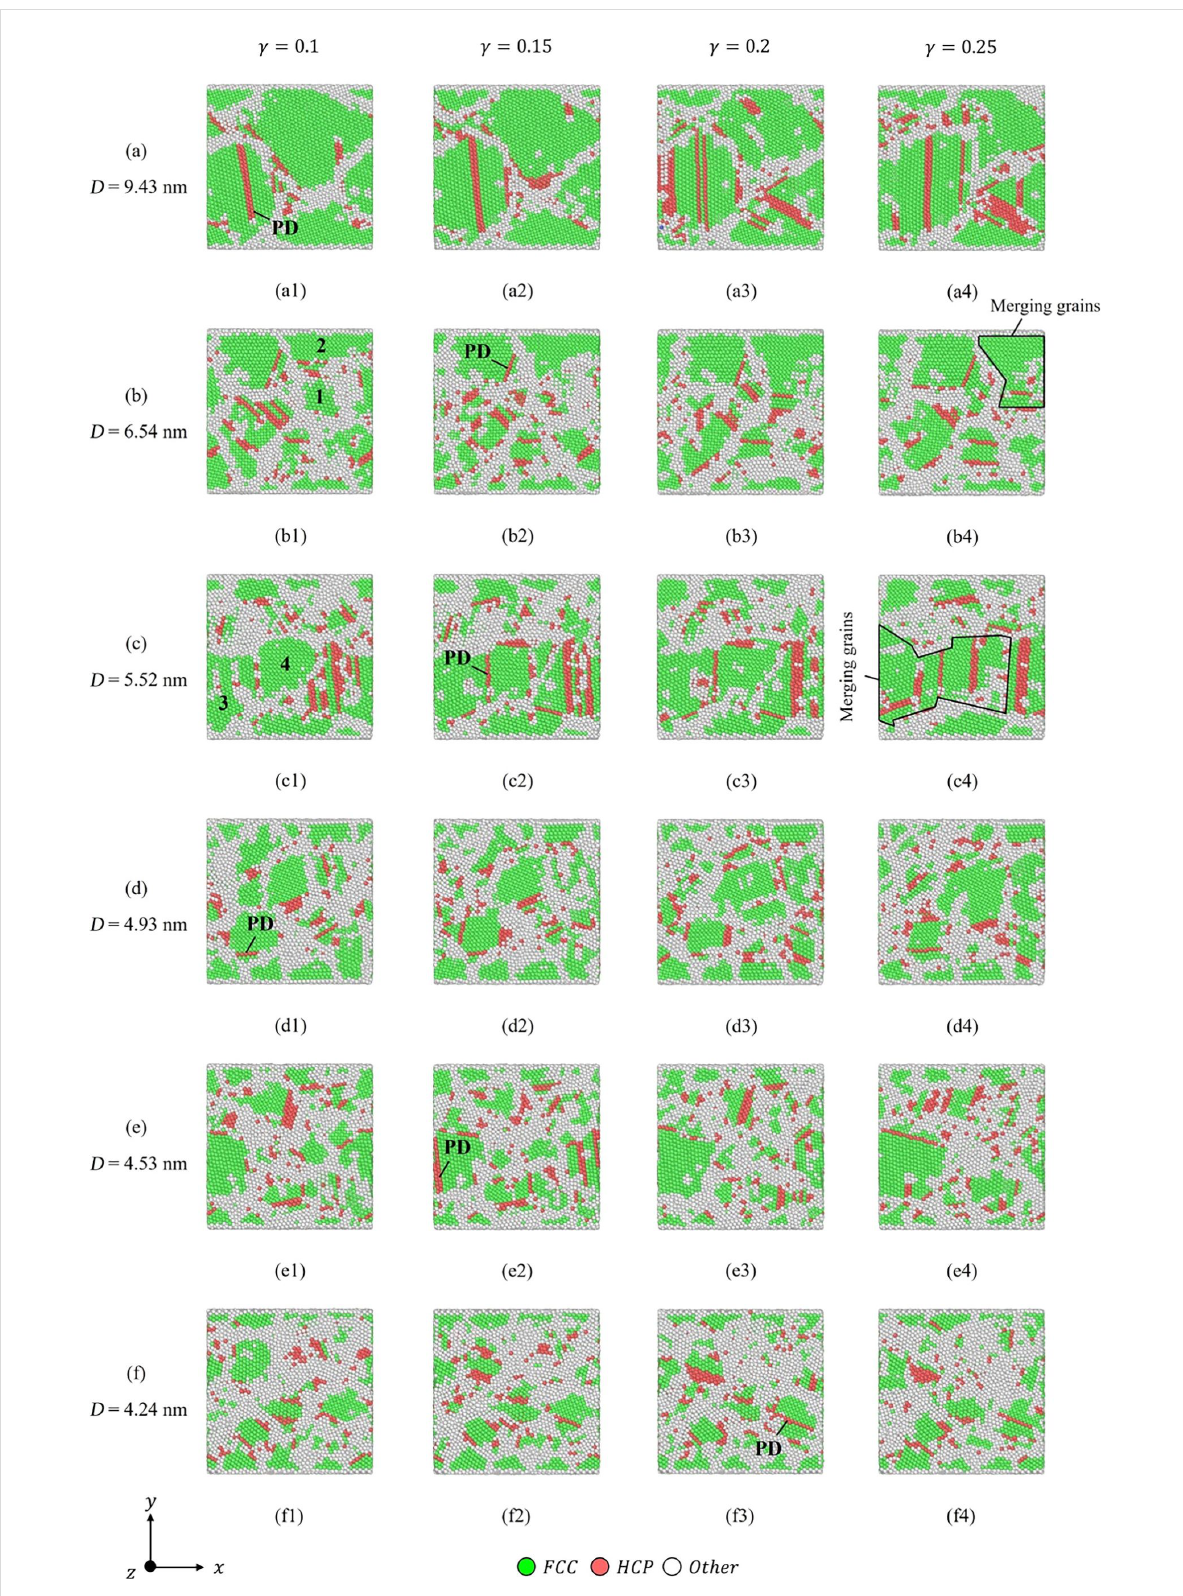
Figure 16: The structural evolution of polycrystalline Cu with different grain sizes. The “PD” symbols represent partial